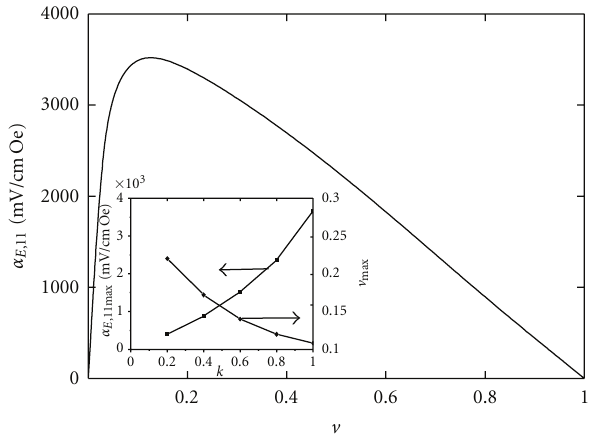
Figure 4: ME voltage coe ffi cient for a perfectly bonded ( k = 1) symmetric structure of CFO and PZT for in-plane longitudinal field orientation. The poling field and DC and AC magnetic and electric fields are in the sample plane and parallel to each other. Inset shows variation of maximum α E ,33 and the corresponding v max with k